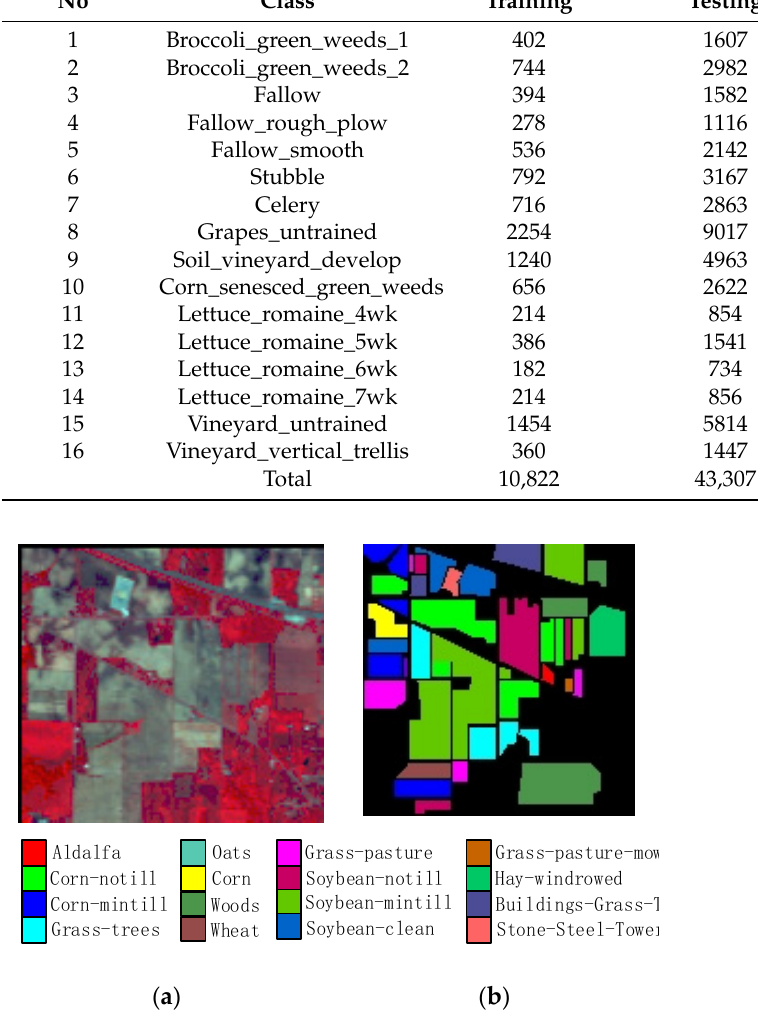
Figure 6. Indian Pines images: ( a ) pseudo-color image; ( b ) ground-truth labels. Table 3. Training and testing samples for the IN Dataset.